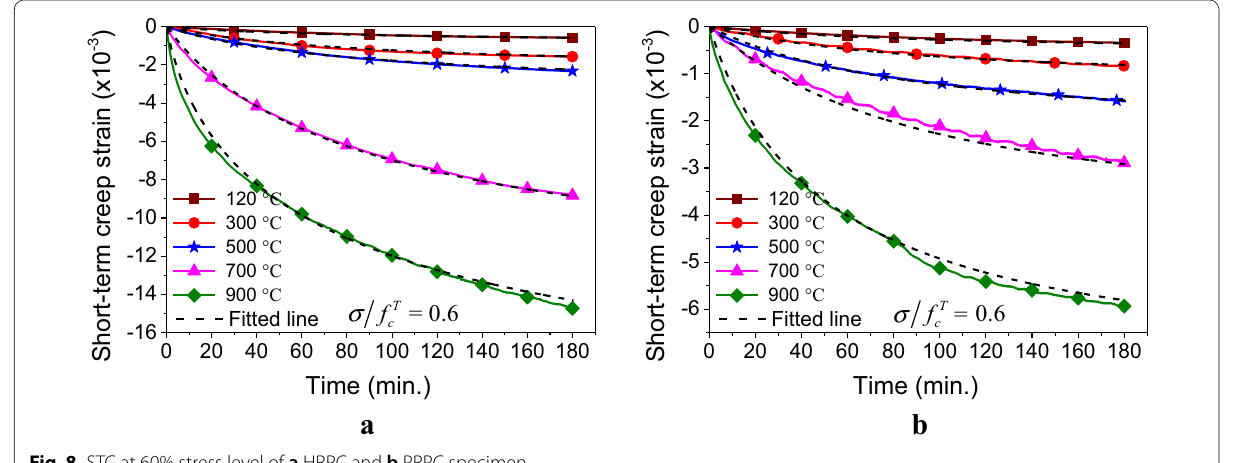
Fig. 8 STC at 60% stress level of a HRPC and b PRPC